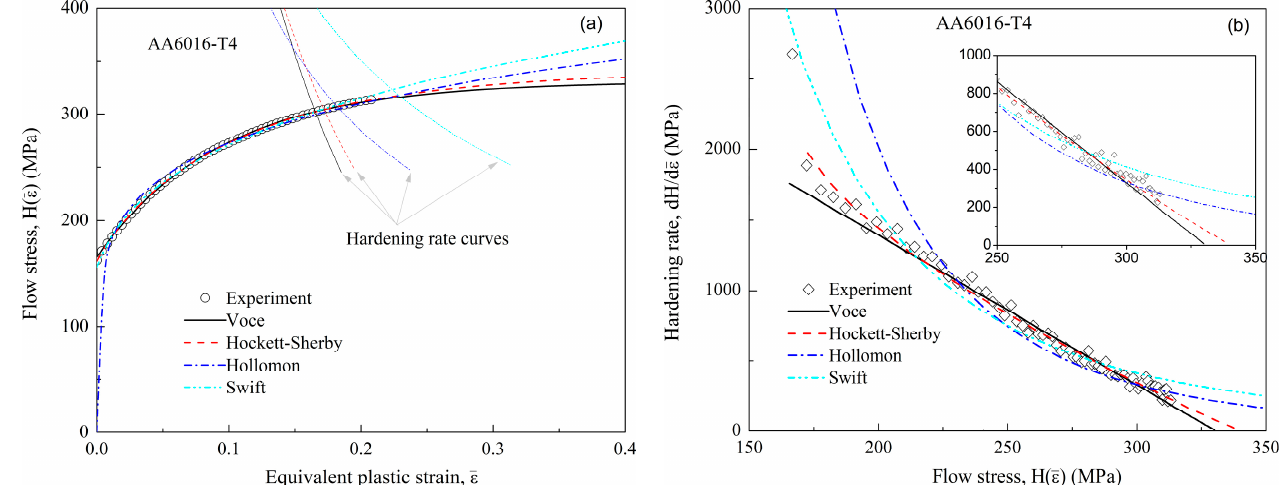
Figure 1. Applications of four hardening laws in capturing the experimental data obtained from the uniaxial tensile test of AA6016-T4 sheets. Experimental data after [11]. ( a ) Stress-strain curves. ( b ) Hardening rate—flow stress curves.